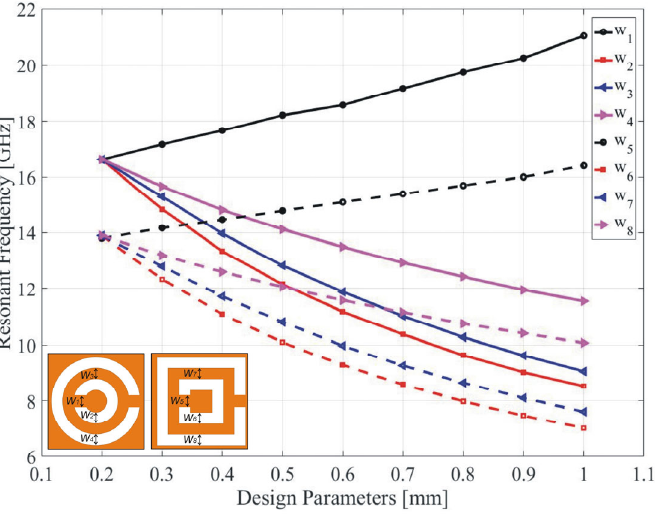
Figure 3. Variation in resonant frequency due to changes in the design parameters of CC ‐ SRR ( w 1 , w 2 , w 3 , and w 4 ) and SC ‐ SRR ( w 5 , w 6 , w 7 , and w 8 ).